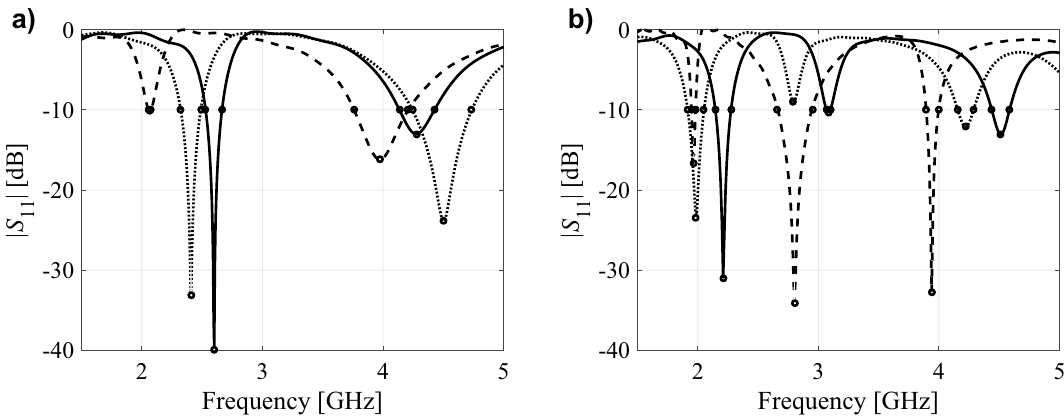
Figure 2. Exemplary antenna responses and their corresponding feature points marked with circles: ( a ) dual-band antenna, ( b ) triple-band antenna. Here, the response features include antenna resonances, as well as − 10 dB reflection levels; observe that not all the features can be distinguished for each antenna response shown in the